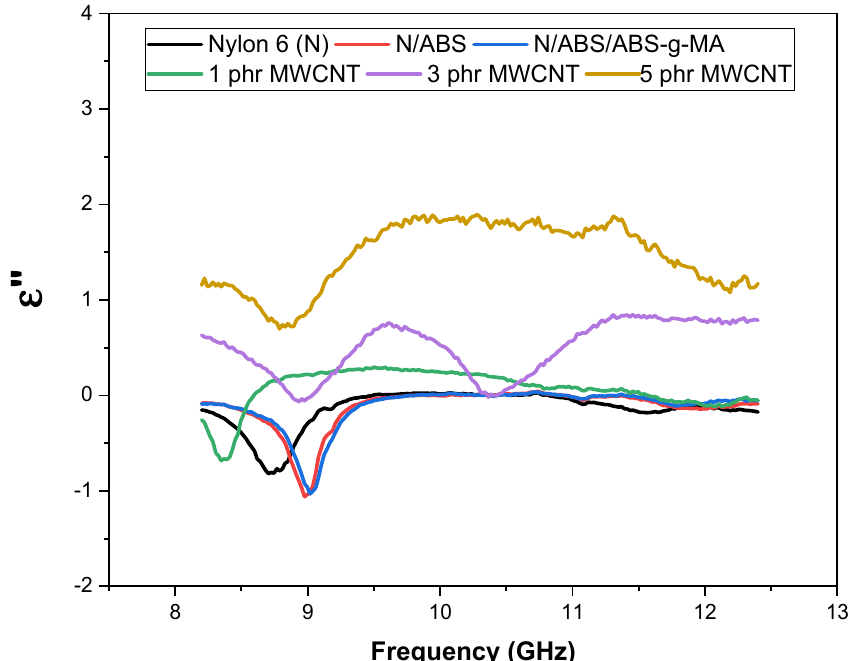
Figure 7. Behavior of dielectric permittivity loss ( ε ”) as a function of frequency of Nylon 6, blends and nanocomposites. N = Nylon and nanocomposites. N = Nylon 6.